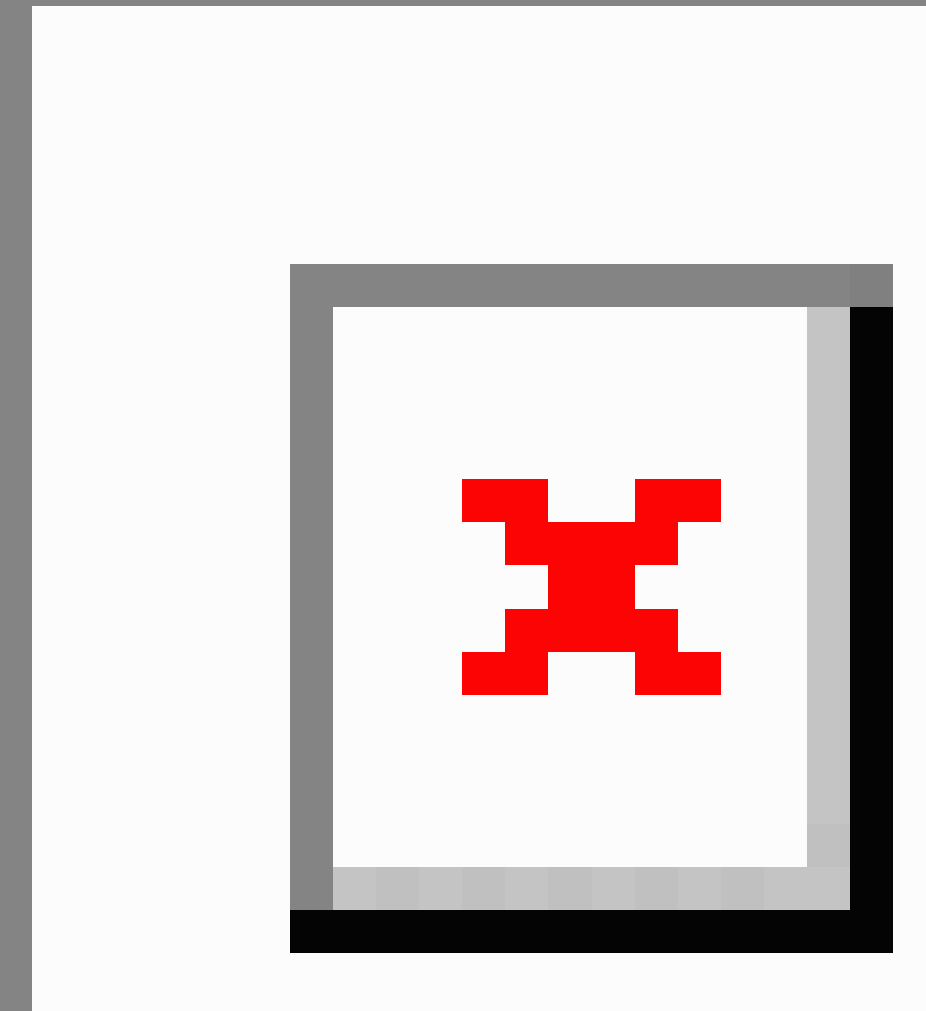
Figure 2. CONSORT flow